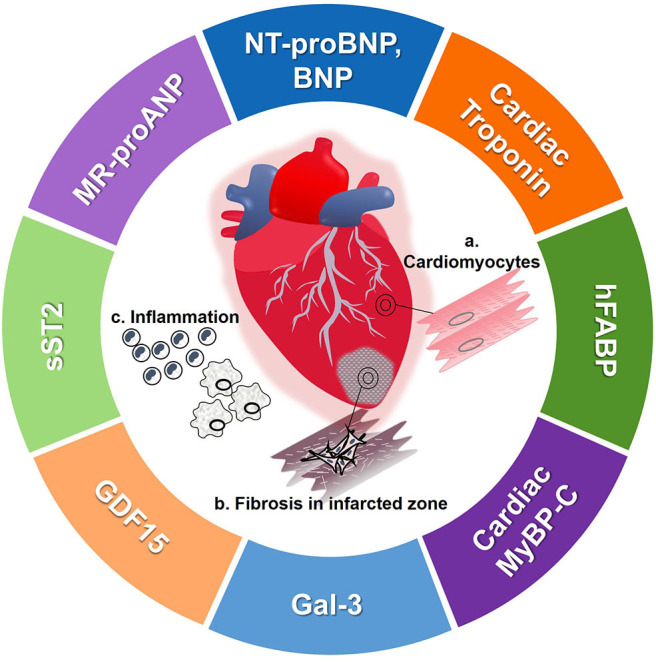
Pictorial representation of protein biomarkers detailed in this paper. (a) During HF, cardiomyocyte damage and restructuring leads to active and passive release of cardiomyocyte specific biomarkers. (b) After an event of myocardial infarction, the cardiomyocytes are destroyed and fibrosis occurs. (c) HF activates inflammatory pathways which also release other biomarkers, representative of systemic inflammation. BNP, brain-type natriuretic peptide; Gal-3, galectin 3; GDF15, growth differentiation factor 15; hFABP, heart-type fatty acid binding protein; MR-proANP, mid-region of N-terminal prohormone of atrial-type natriuretic peptide; MyBP-C, myosin binding protein-C; NT-proBNP, N-terminal prohormone of BNP; sST2, soluble suppression of tumorigenicity 2.